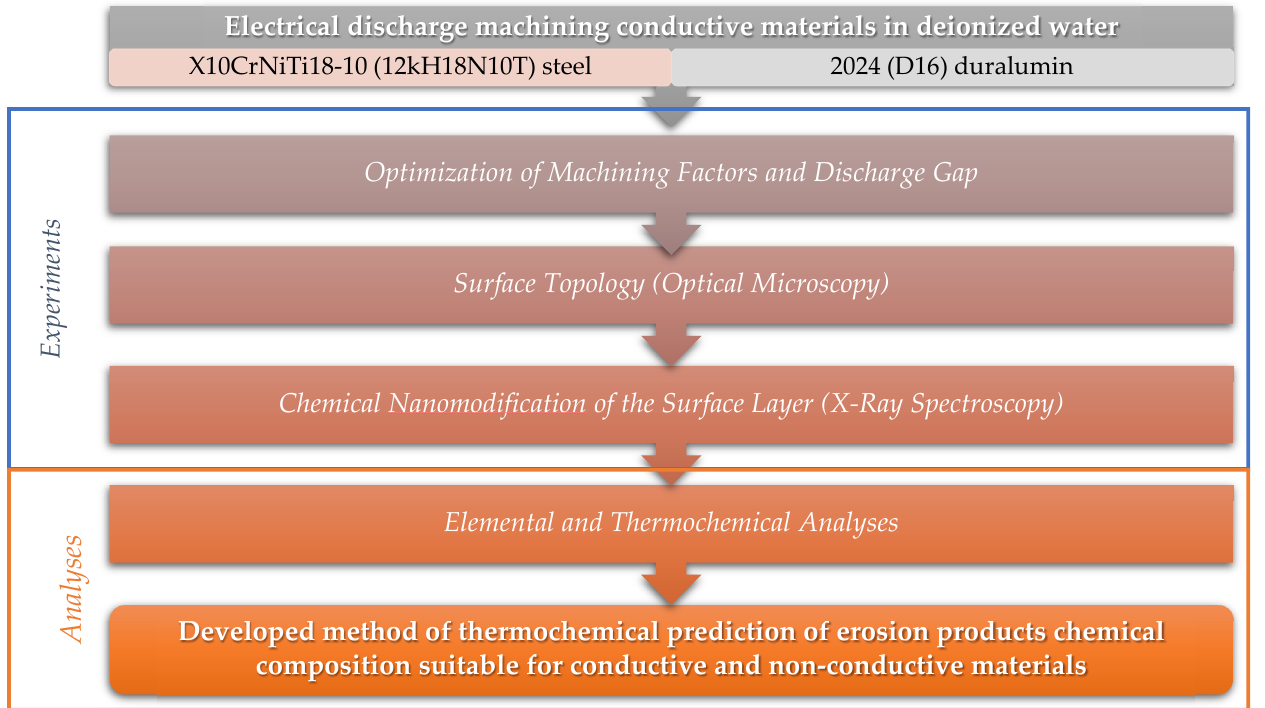
Figure 1. Flow chart of the stepwise procedure of experiments and analyses carried out.